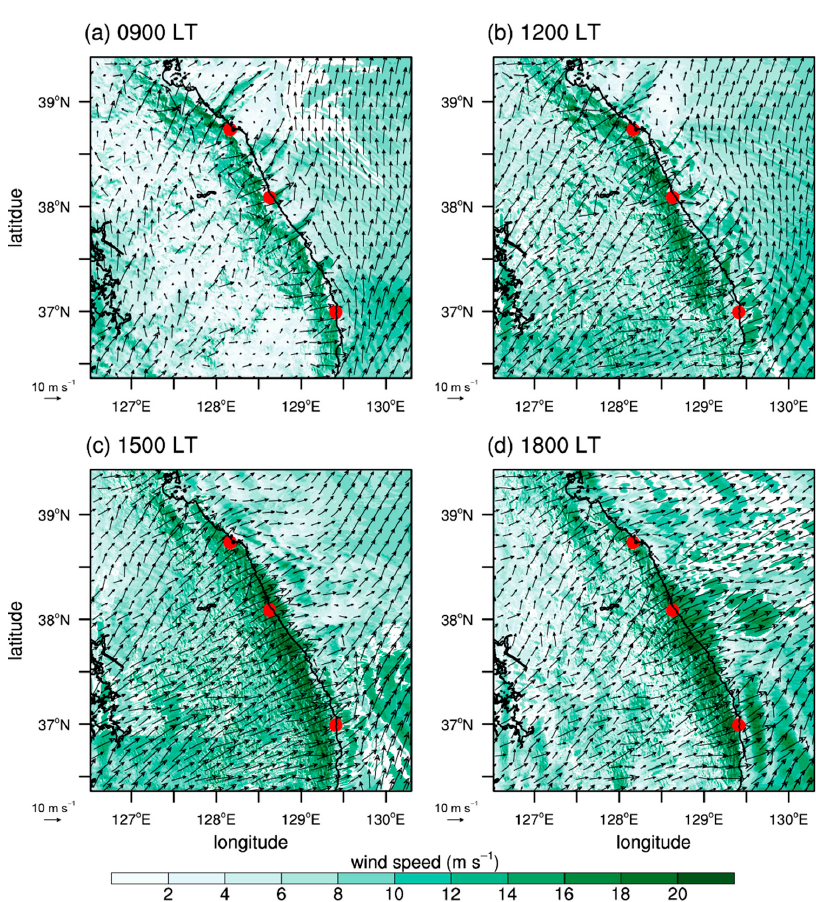
Figure 5. Simulated 10-m wind speed and wind vector fields at ( a ) 0900 LT, ( b ) 1200 LT, ( c ) 1500 LT, and ( d ) 1800 LT. The red dots indicate the locations of Jangjeon, Yangyang, and Uljin stations.